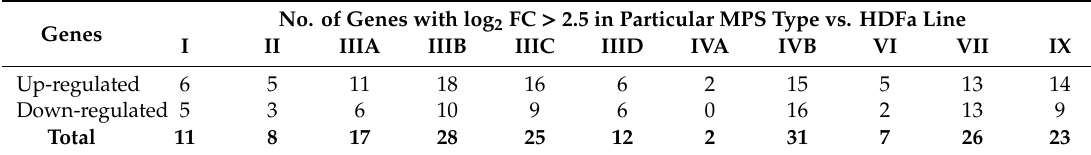
Table 3. Number of up- and down-regulated genes with log 2 FC > 2.5 in di ff erent types of MPS relative to control cells (HDFa).